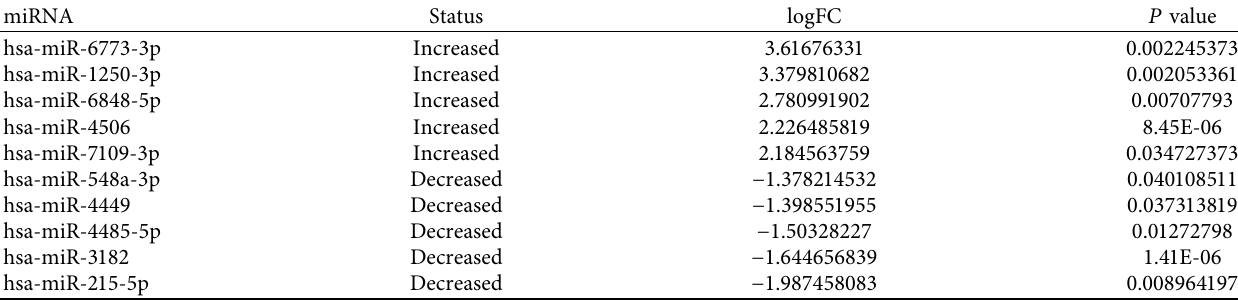
Table 2: Top 5 increased and decreased DEmiRNAs.